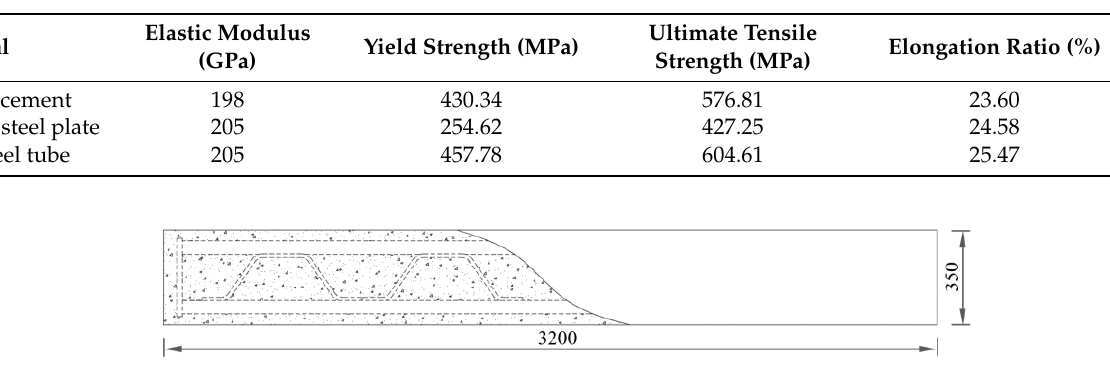
Table 2. Mechanical properties of the steel materials.